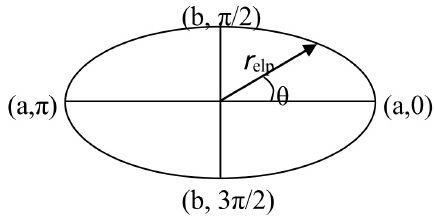
Figure 12. Ellipse border representation using the polar coordinate